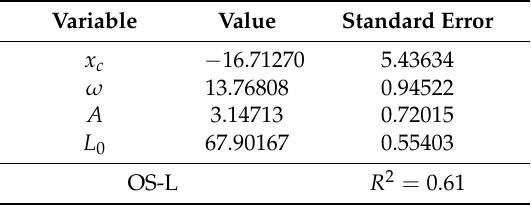
Table 14. Correlation modeling between Relative Humidity and Noise Level at OS-L.